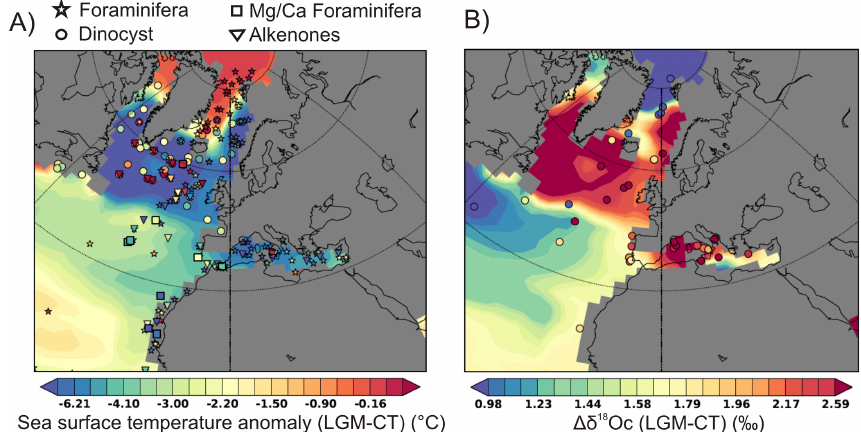
Figure 11. A focus on the North Atlantic region with (a) the comparison between simulated SST anomaly (LGM-CT) in i LOVECLIM and MARGO reconstructions for each temperature proxy (MARGO Project Members, 2009). (b) The comparison between simulated sur- face ocean calcite δ 18 O anomaly (LGM-CT) in i LOVECLIM (0–50m) and planktic foraminifera δ 18 O data (Table S1). For colour scale generation explanations see Fig. 1